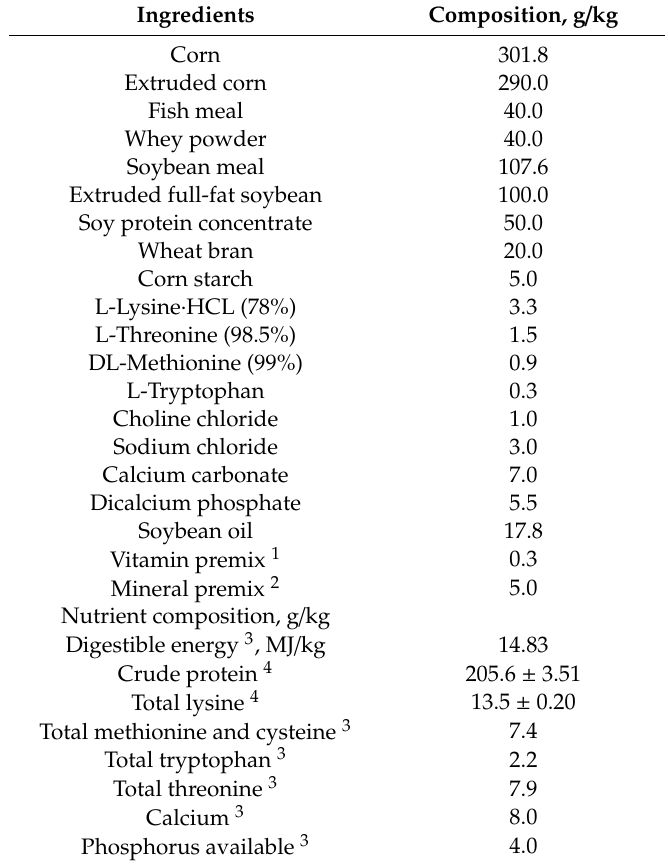
Table 2. The composition and nutrient content of basal diet (as-fed